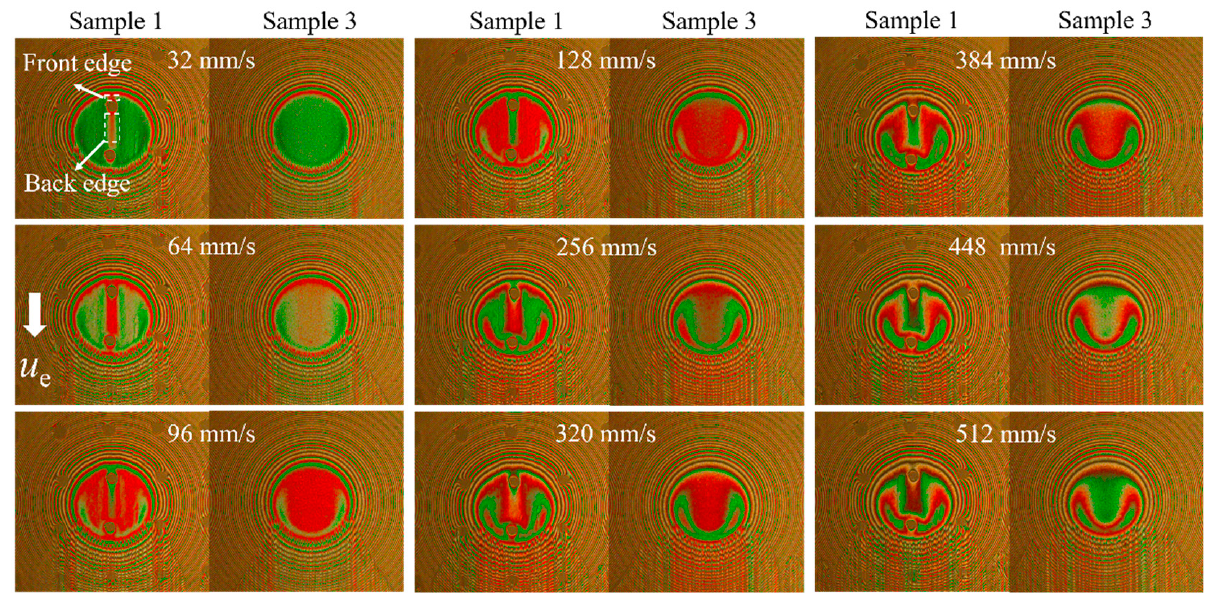
Figure 4. Interference images of sample 1 and sample 3 at different sliding speeds (load = 16.7 N). The film thickness profiles of sample 1 and sample 3 along the x and y directions at three different speeds were presented to further analyze the influence of sliding speeds on film thickness distributions. The results are shown in Figure 5, where x and y axes were perpendicular and parallel to the sliding velocity, respectively. It should be noted that since the depth of the dimples was much larger than the film thickness, the morphology of the texture could not be fully shown in the contour figure. Two vertical lines were used to represent the texture edge in Figure 5. Moreover, the center distance between two dimples was 200 µ m while the diameter of hertz contact area was close to 200 µ m under a load of 16.7 N, which led to the existence of two dimples in the contact area simultaneously with one of the dimples located at the entrance of the contact region. The influence of the dimple located at the entrance of the contact region was discussed and the other was ignored. The change in film thickness could be judged by different interference fringe orders in the interference images. The area outlined by yellow and black dashed lines in Figure 5 represents the increasing film thickness areas and decreasing film thickness areas, respectively. When the sliding speed was 32 mm/s, a narrow increasing film thickness region formed at the back edge of the dimple and two sides. Comparing the profile of the film thickness along the x axis in Figure 5b, the decreasing film thickness region was not as obvious as the increasing film thickness region. When the sliding speed was 256 mm/s, the increasing film thickness area enlarged, and the decrease in film thickness at both sides of the dimple became more apparent. When the sliding speed was 512 mm/s, the proportion of the increasing film thickness area remained almost unchanged, but the decreasing film thickness area became smaller and only presented at both sides of the dimple, as shown in Figure 5e. To intuitively express the oil film thickness increase at the back edge of the texture, Figure 6 compares the central film thickness of sample 1 at the junction of the x and y axes with sample 3. In general, the increase in film thickness continuously enhanced with increasing sliding velocities. The central film thickness of textured ball was higher than the untextured steel ball under the same sliding speeds in the